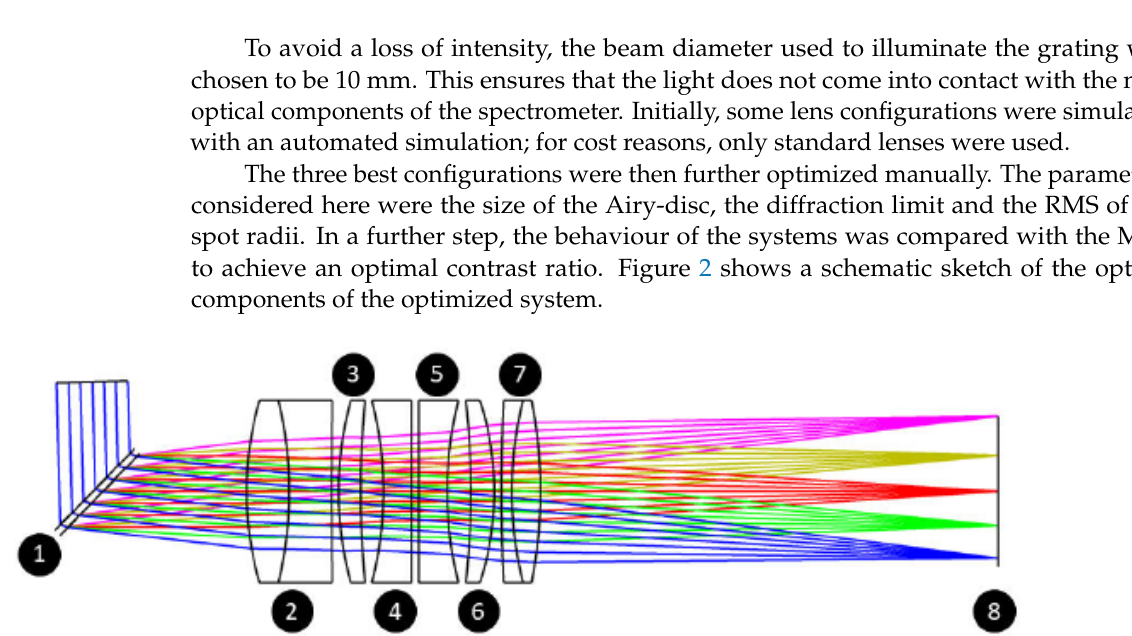
Figure 2. Final system model of the spectrometer beam shaping. The installed components are as follows: transmission grating NIR-1500-903 from Ibsen Photonics (1); lens package from Thorlabs consisting of AC254-125-B, LE1104, LC1120, LC1120, LE1156 and AC254-100-B (2 to 7); line scan camera AViiVA M2 CL 2010 from e2v (8).